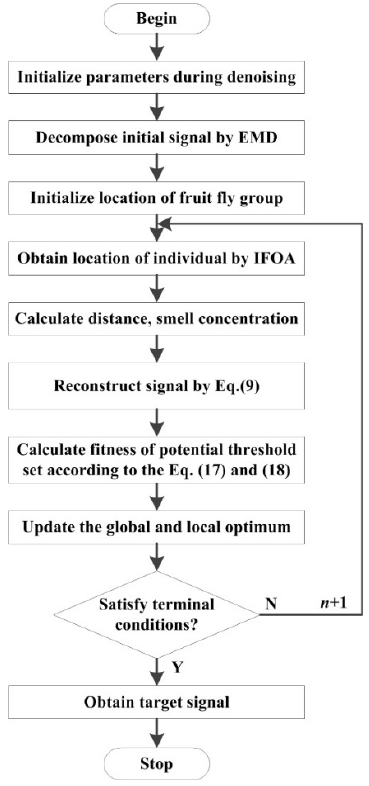
Figure 3. Flow of the proposed empirical mode decomposition ‐ improved fruit fly optimization algorithm (EMD ‐ IFOA).